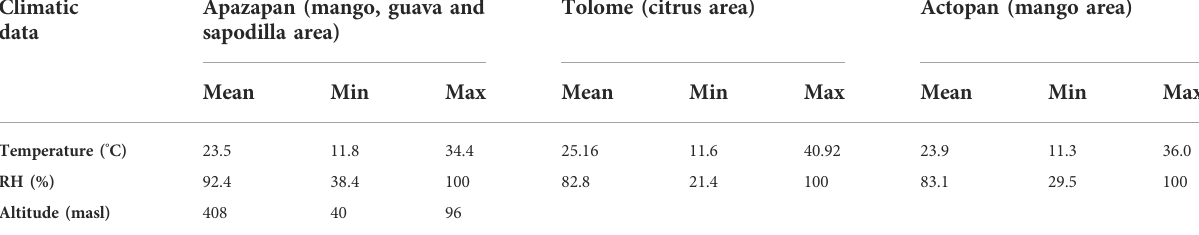
TABLE 5 Climatic data of fi eld study sites in Veracruz, Mexico. Climatic Apazapan (mango, guava and data sapodilla